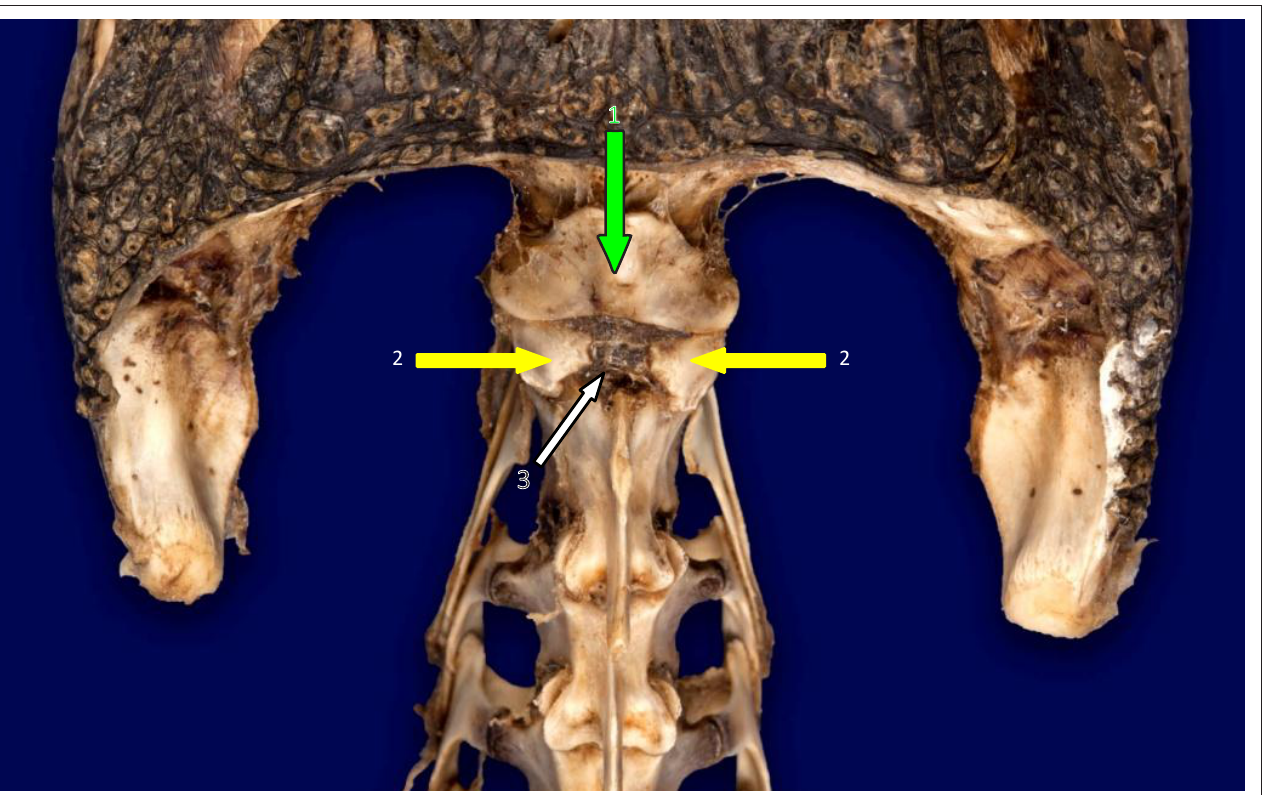
FIGURE 1: The base of the head and post-occipital cervical vertebrae of a young Nile crocodile in situ after removal of the surrounding soft tissue by necrophageous insects.